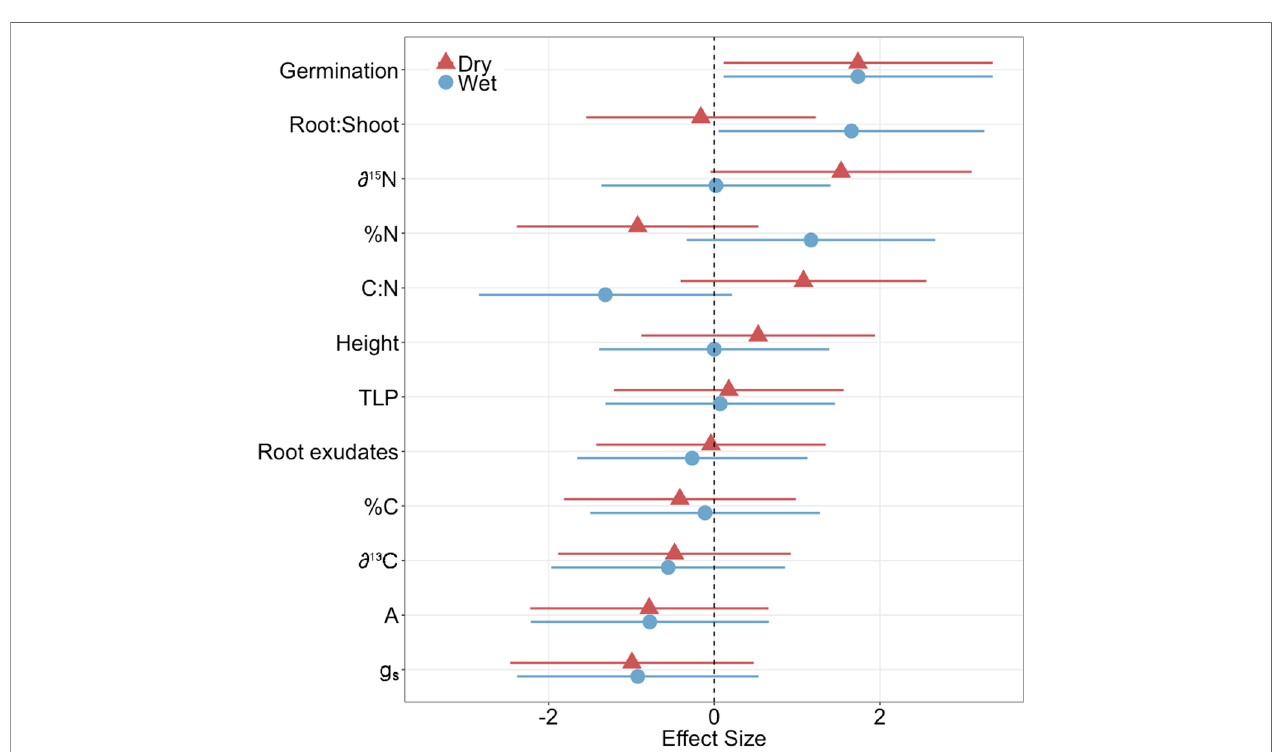
FIGURE 1 | Effect size of inoculation treatment on physiological measurements in dry and wet families (germination, root:shoot biomass ratio, leaf N isotope ratio ( d 15 N), leaf N content (%N), leaf C:N ratio (C:N), height, turgor loss point ( Y TLP ), root exudate concentration, leaf C content (%C), leaf C isotope ratio ( d 13 C), photosynthesis (A), stomatal conductance (g s )). A positive effect size indicates an increase in the physiological measurement. Bars represent 95% con fi dent intervals. Effect sizes were considered signi fi cant if the 95% con fi dence intervals did not overlap with an effect size of zero. N = 4. Seedlings were ~11 months old for all measurements except germination (14 days old) and height (~9 months